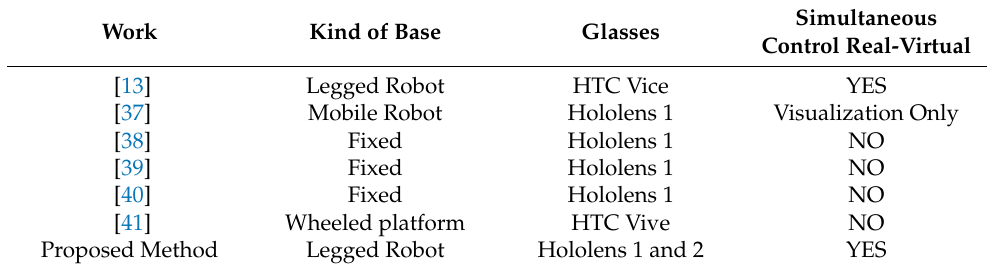
Table 4. Comparison of related works in the